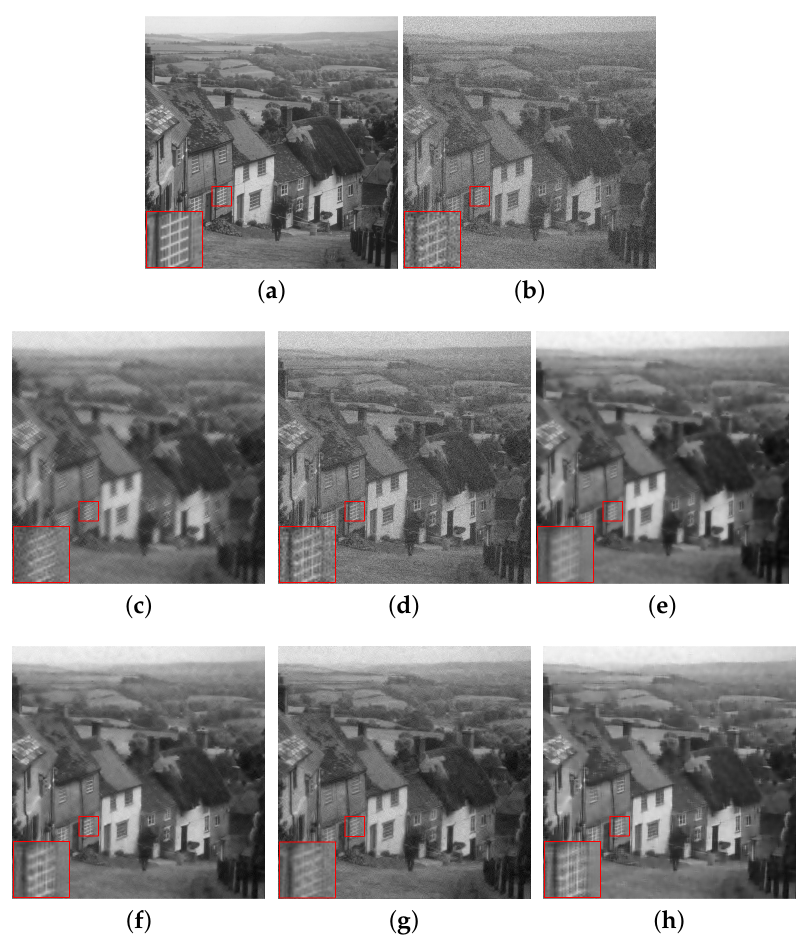
Figure 4. Comparison of the denoising results (PSNR/SSIM) of all the algorithms on the standard hill image with σ = 25, where s = 10. ( a ) Original image; ( b ) noise image ( σ = 25); ( c ) SG-HT (25.58/0.5711); ( d ) OMP (21.90/0.4065); ( e ) GraSP (27.01/0.6748); ( f ) SVRGHT (28.16/0.7012); ( g ) LSSG-HT (27.86/0.7095); ( h ) SRGSP